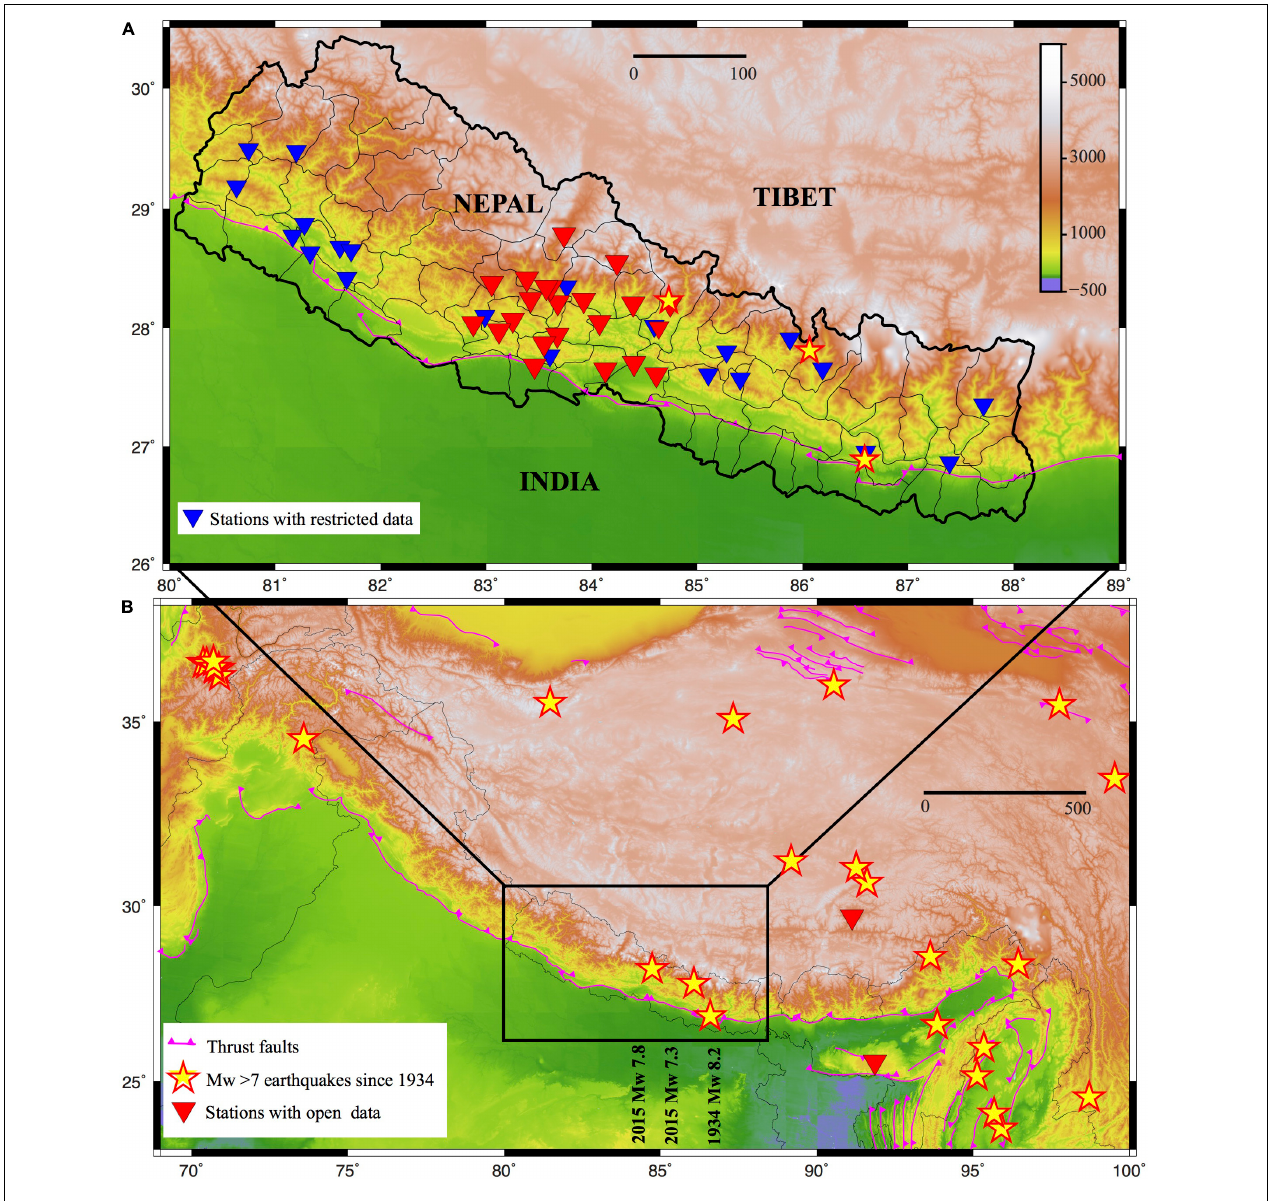
FIGURE 1 | Studied area maps. (B) The Himalaya-Tibet region, with large and great earthquakes ( M ≥ 7) since 1934 from the USGS catalog (https://earthquake.usgs.gov/earthquakes/search/). Permanent seismic stations with open data are shown in red. (A) Focus on Nepal, showing 21 permanent seismic stations of the National Seismological Center with restricted data in blue, and 22 Nepal School Seismology Network (this project) stations in Western Nepal with open data in red. Pink lines are thrust faults in the area (Styron et al., 2010). Distance scales are in